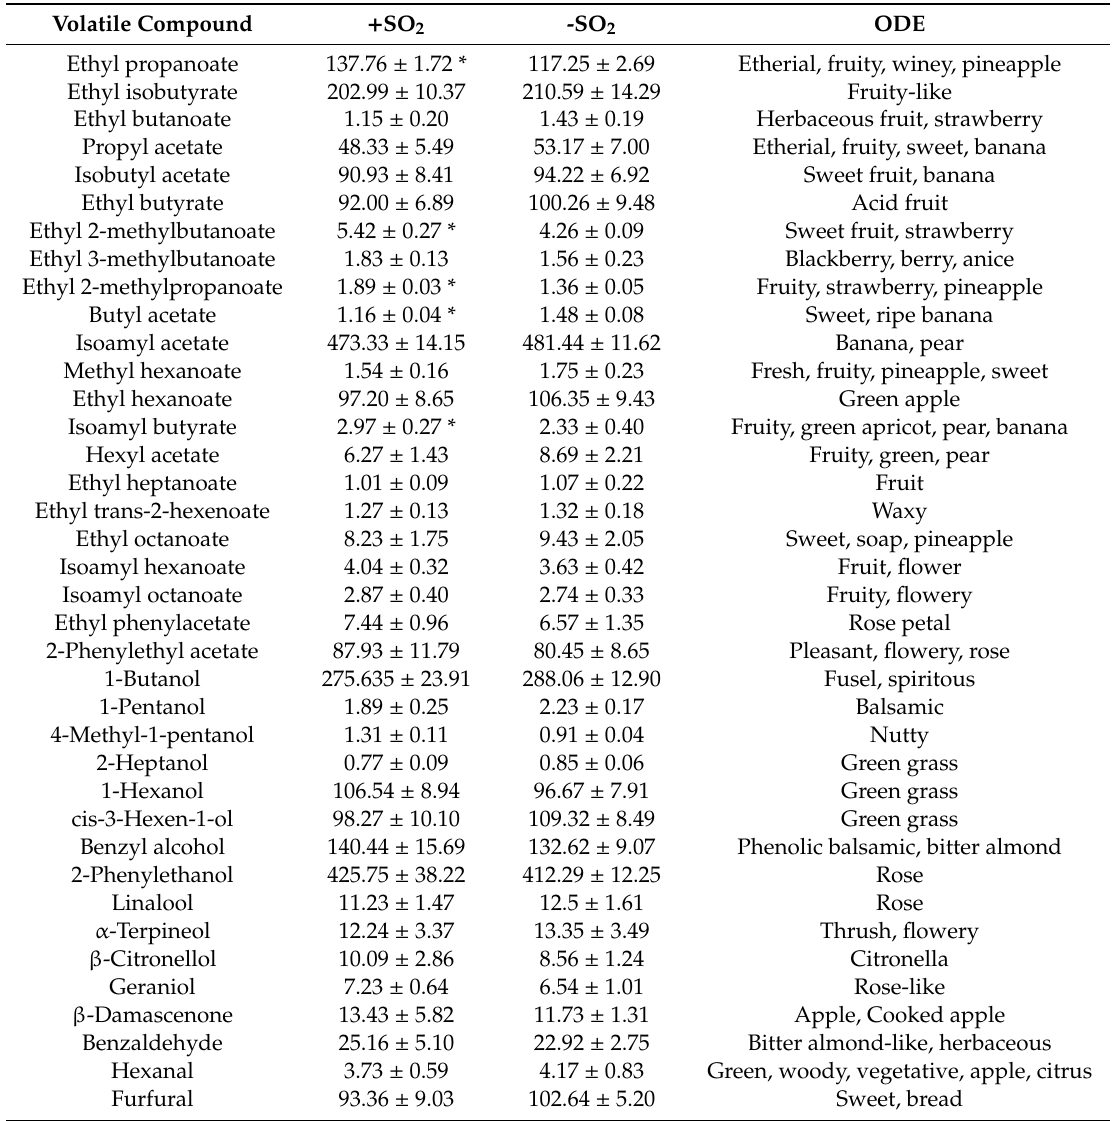
Table 4. Data (mean ± SD) of volatile compounds (mcg / L) determined by SPME in wines obtained with the mixed starter culture ND-SA in two vinification protocols: grape must with ( + SO 2 ) and without SO 2 addition (-SO 2 ). Odor descriptors (ODE) described in the literature are reported [53–58]. One-way ANOVA analysis and Tukey test were applied. * Significant di ff erences between two wines at p ≤